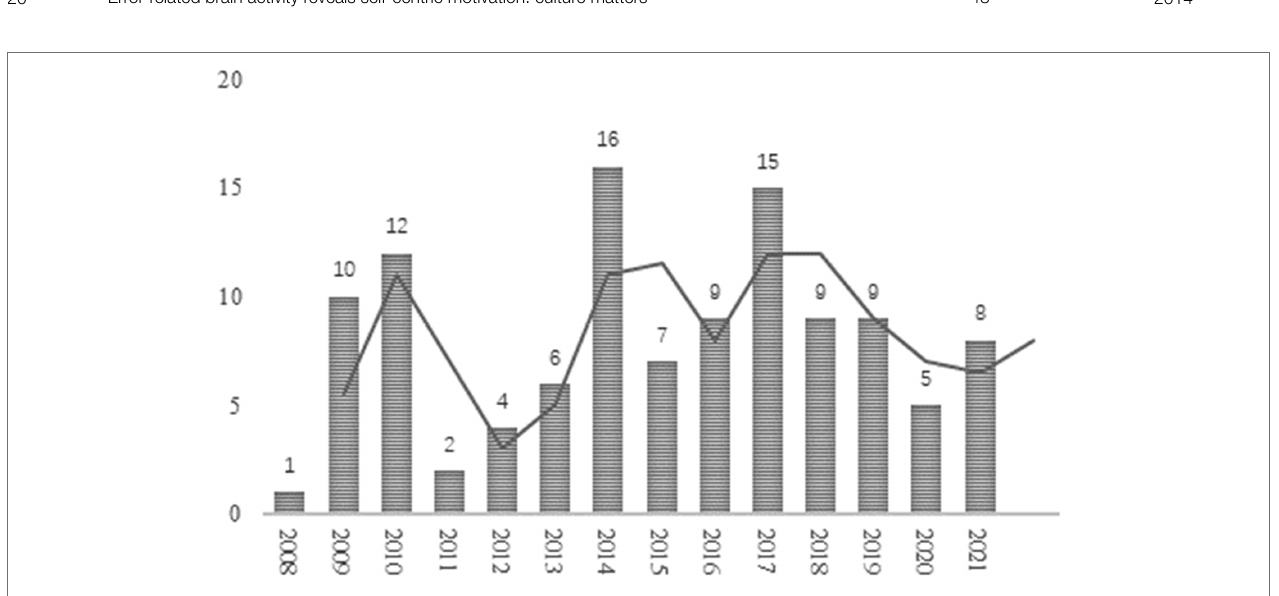
FIGURE 1 | Trends in publications in the field of cultural neuroscience.